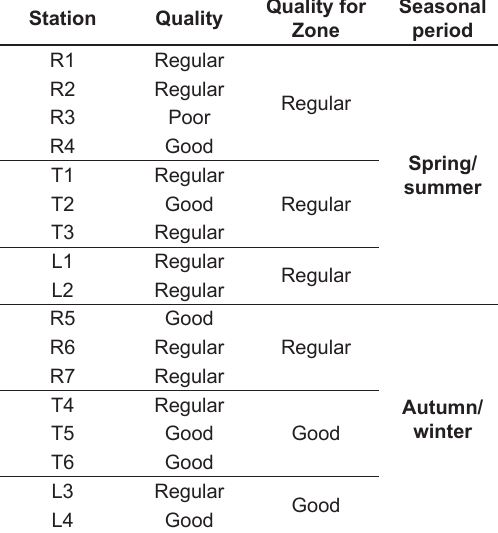
Table 7. Water quality ranking system based on benthic macroinvertebrates for each sampling station, zone and seasonal period obtained with ICB RES-P